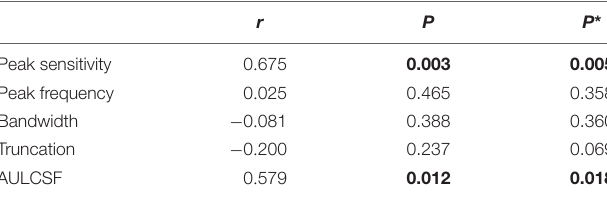
sensitivity) is associated with the parvocellular pathway. While the precise mechanisms by which this cross-pathway effect is